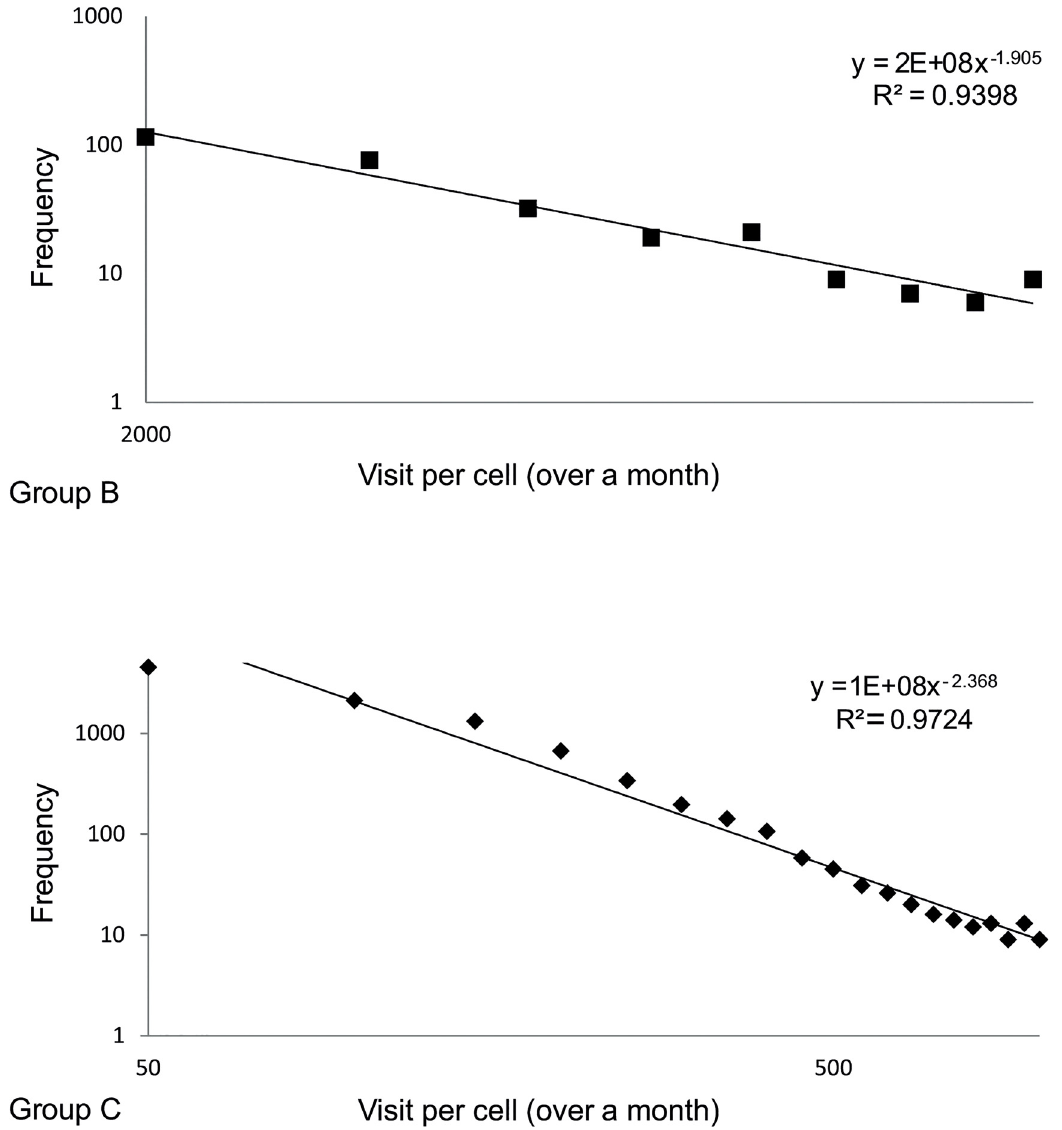
Fig 7. Distribution of visits per cell for group B and group